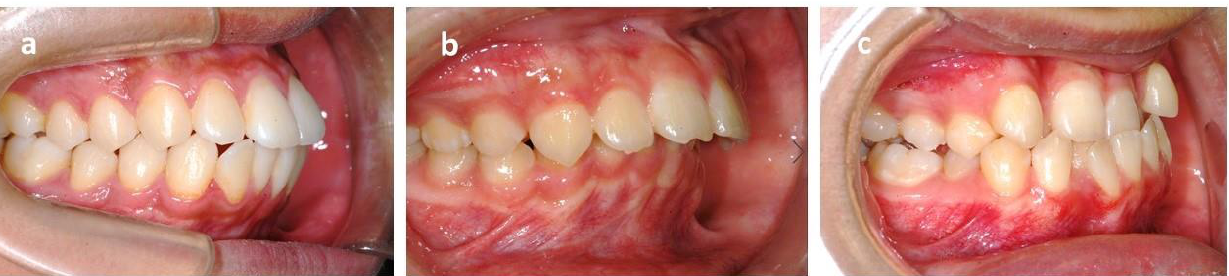
Figure 3. Angle’s classification of malocclusion. ( a ) Class I molar relationship: the mesiobuccal cusp of the upper first molar occludes the mesiobuccal groove of the lower first molar. ( b ) Class II molar relationship: the mesiobuccal cusp of the upper first molar occludes in front of the mesiobuccal groove of the lower first molar. ( c ) Class III molar relationship: the mesiobuccal cusp of the upper first molar occludes behind the mesiobuccal groove of the lower first molar.